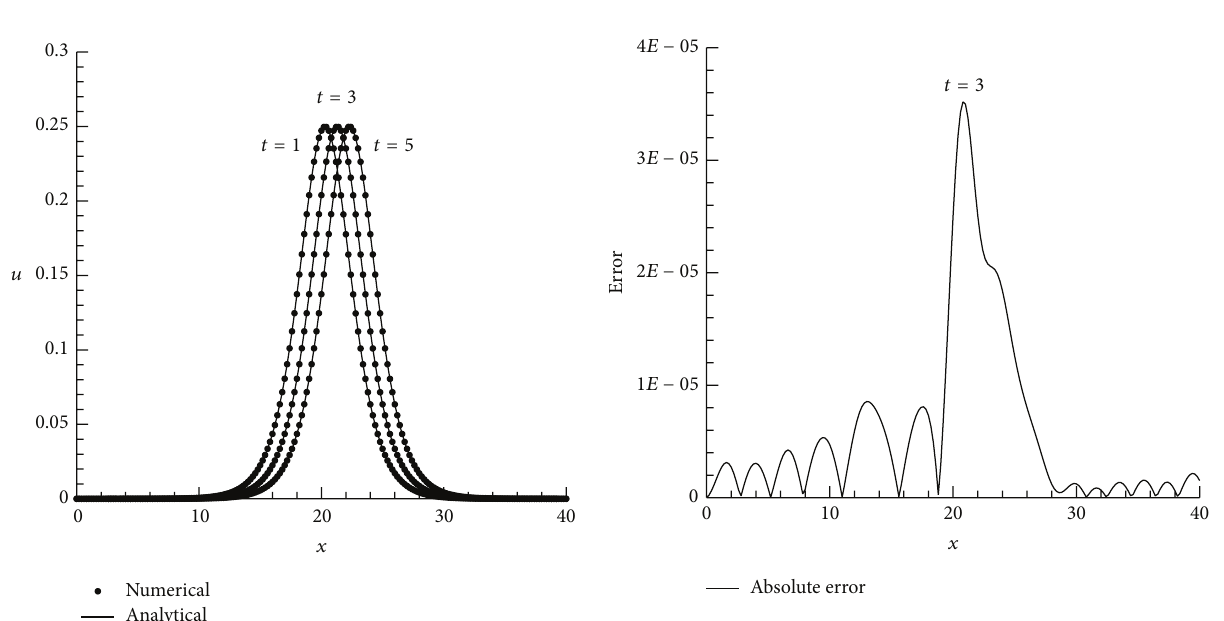
Figure 3: Numerical and analytical solutions for equation 𝑢 𝑡 + 6𝑢𝑢 𝑥 + 𝑢 𝑥𝑥𝑥 = 0 with initial condition 𝑢(𝑥,0) = (𝑐/2) sech 2 ((√𝑐/2)𝑥 − 7), 0 ≤ 𝑥 ≤ 40, 𝑐 = 0.5 of Example 3 at various time stages and the absolute error for 𝑡 = 3